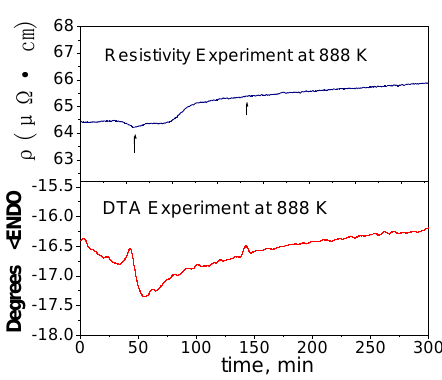
Figure 11. ρ- T curves of Sn-Sb5wt% melt.